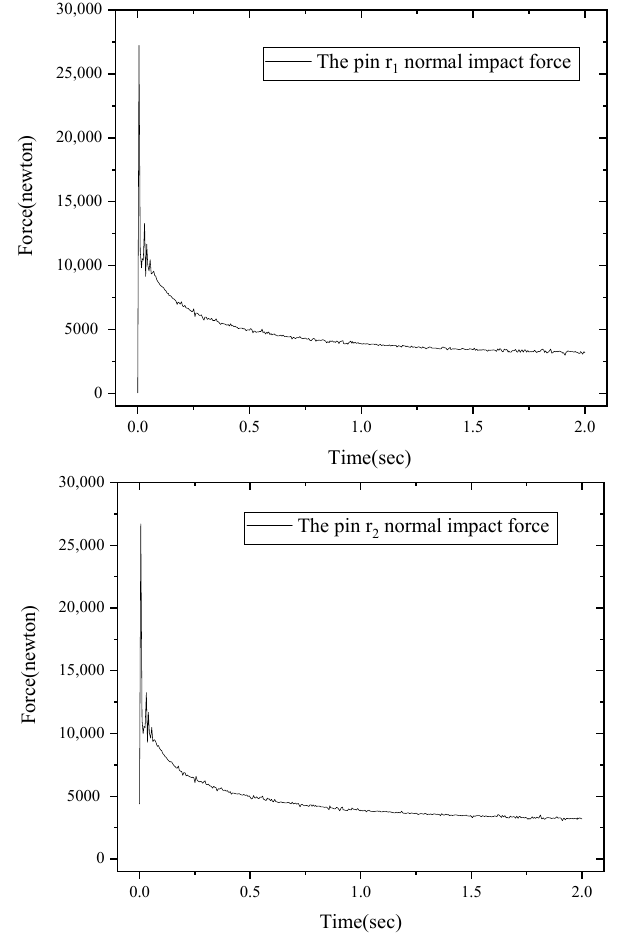
Figure 4. Normal pressure diagram at different pins.